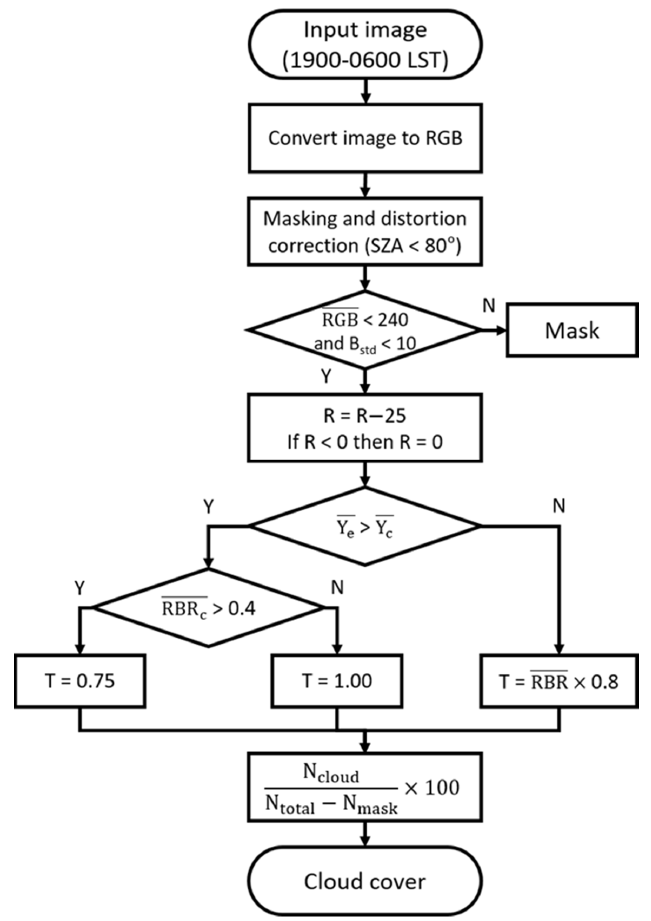
Figure 3. Flow chart of the nighttime cloud cover calculation algorithm of ACOS. The average red, green, and blue (RGB) brightness and red–blue ratio (RBR) is RGB and RBR , respectively. The average luminance of the edge (SZA 60–80 ◦ ) and center (SZA 0–20 ◦ ) region is Y e and Y c , respectively. RBR c is the average RBR of the center region. T is the RBR threshold.